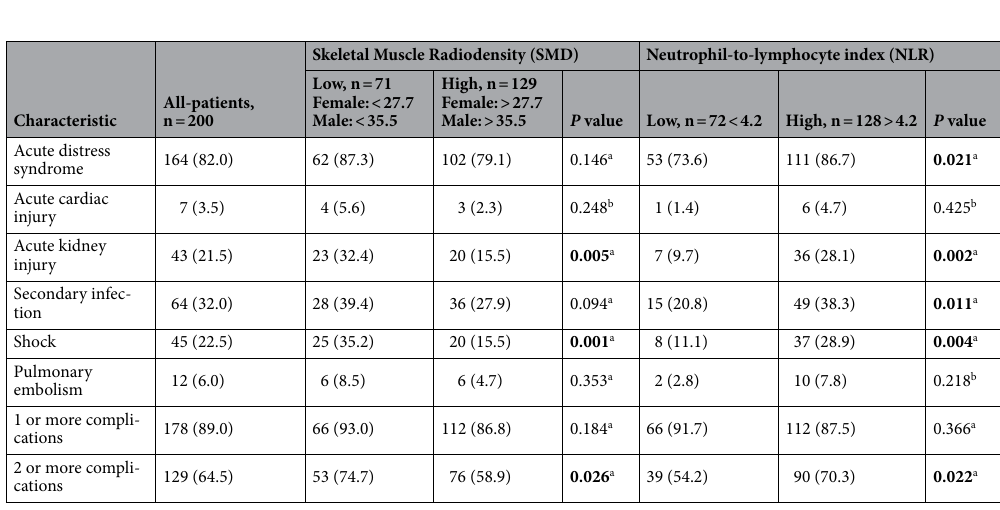
Table 2. Selected complications according to skeletal muscle radiodensity (SMD) and neutrophil-to- lymphocyte ratio (NLR) of patients with COVID-19. a Chi-square test. b Fisher’s exact test. Bold indicates P value is statistcally